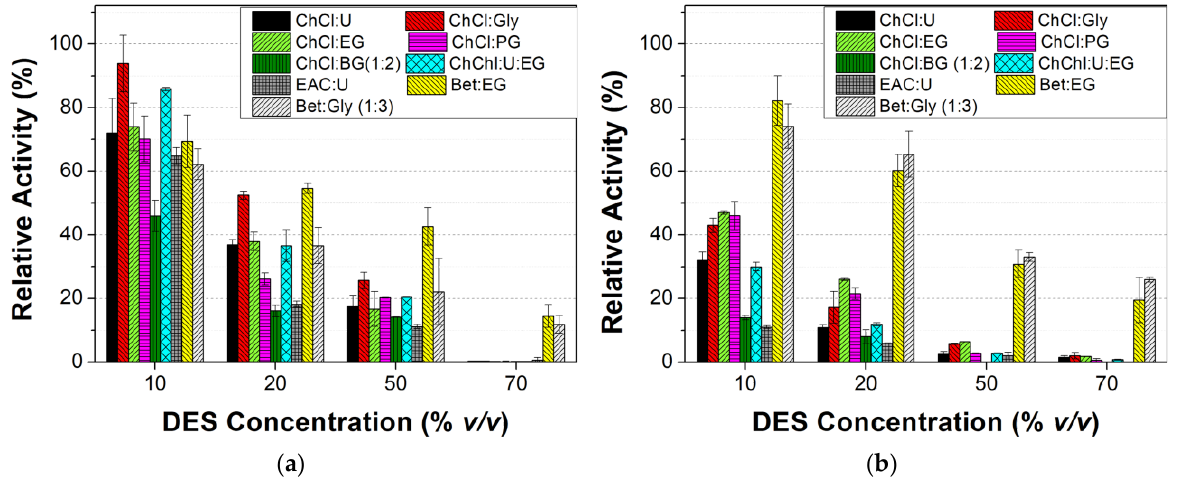
Figure 6. Relative activity of ( a ) tyrosinase mCLEAS and ( b ) free tyrosinase at increasing concentra- tions of certain DESs. 100% is defined as the activity of tyrosinase mCLEAs or free tyrosinase in DES-free solution.